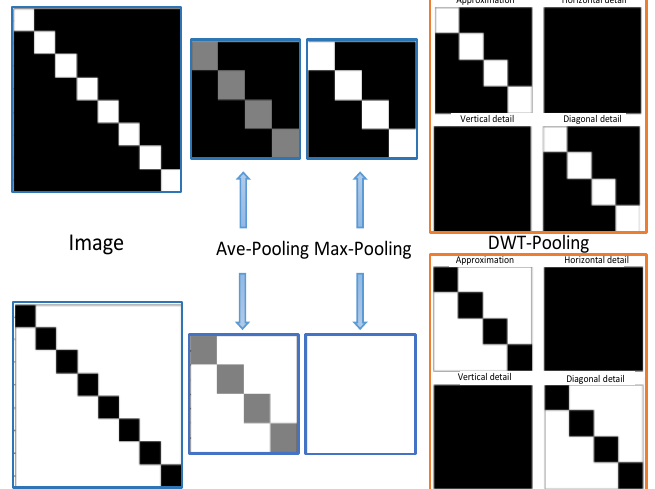
Figure 1. Example of the shortcoming of Max and Average Pooling against the contribution of wavelet pooling, preserving the essential